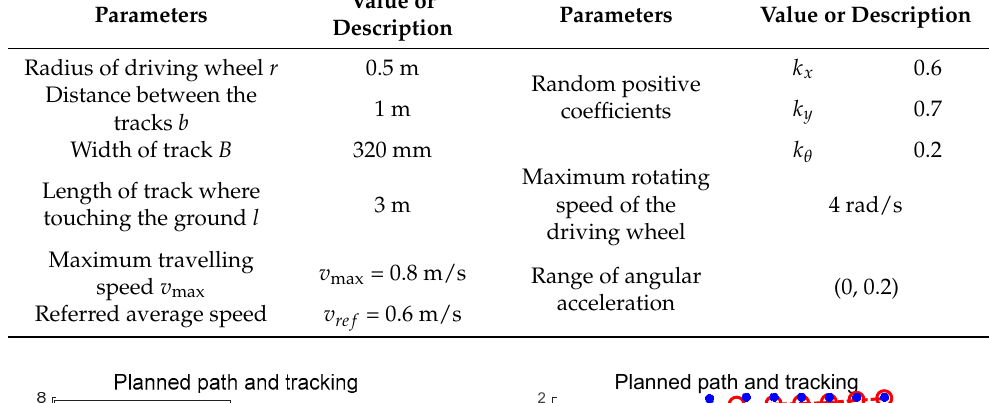
Table 1. The data used in simulations.